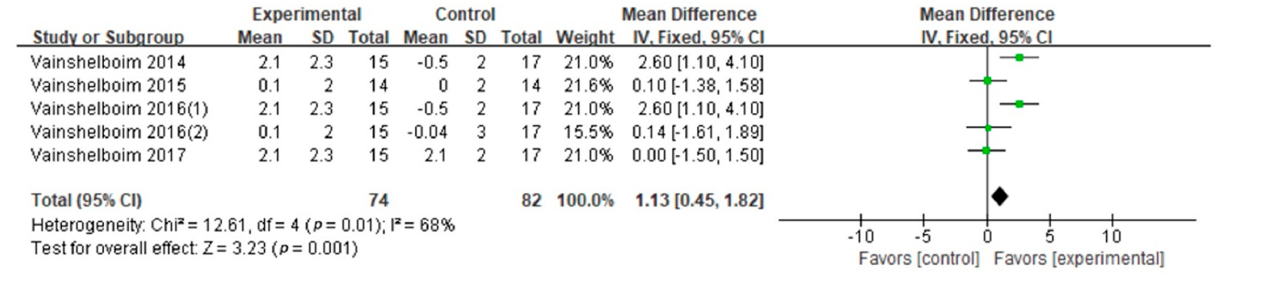
Figure 3. Peak VO 2 .